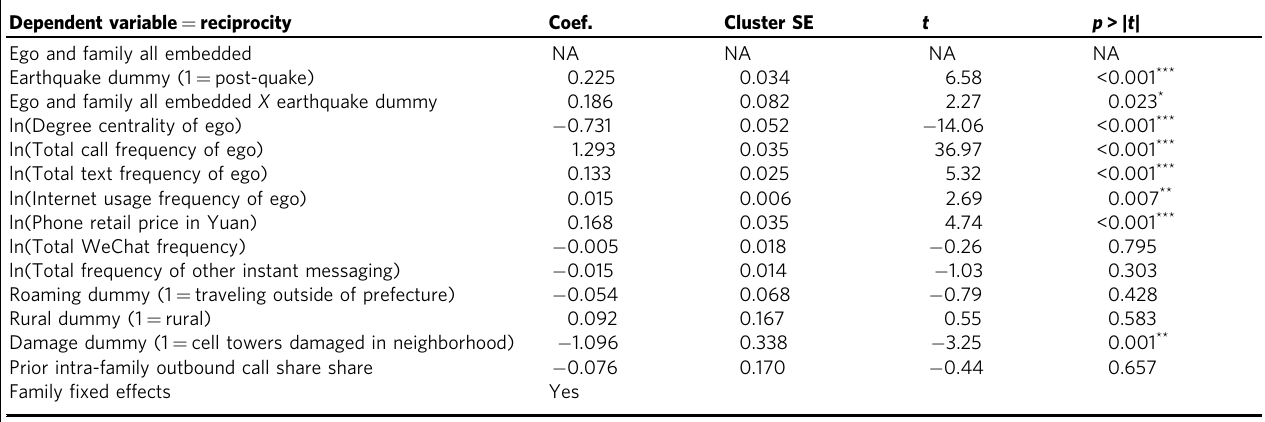
Table 3 Communications reciprocity after